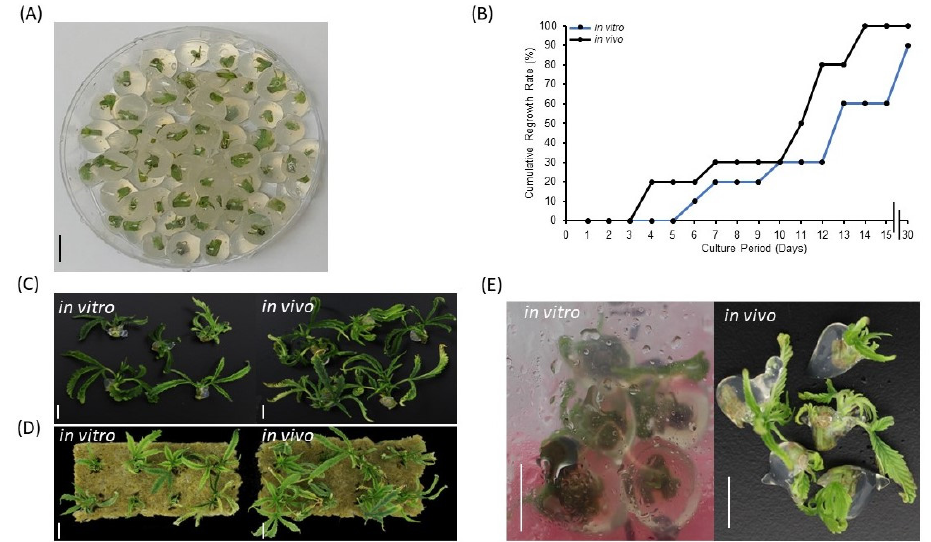
Figure 1. Regrowth of cannabis synseeds. Encapsulated nodal segments using calcium alginate matrix to yield 10 mm cannabis synseeds ( A ), regrowth rates of in vitro- and in vivo-derived synseeds on MS medium without a storage period up to 30 days culture ( B ), plantlets after 30 days of regrowth on MS Cannabis medium ( C ), and on sterile rockwool ( D ). Precocious germination of in vitro and in vivo - derived synseeds during the first 15 days of storage at 22 °C ( E ). Scale bars represent 1 cm.